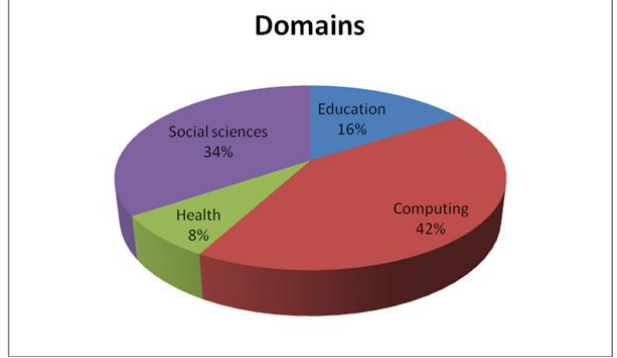
Figure 3 . Different domains (2012-2015)